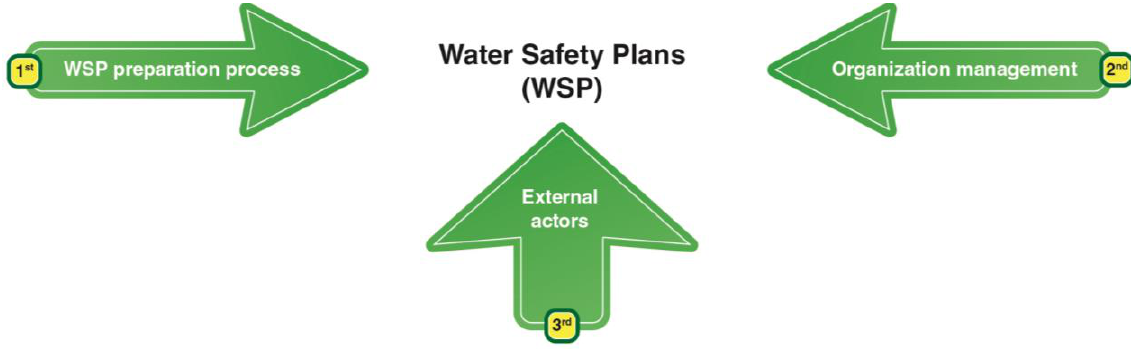
Figure 4. Factors that affect the WSP.